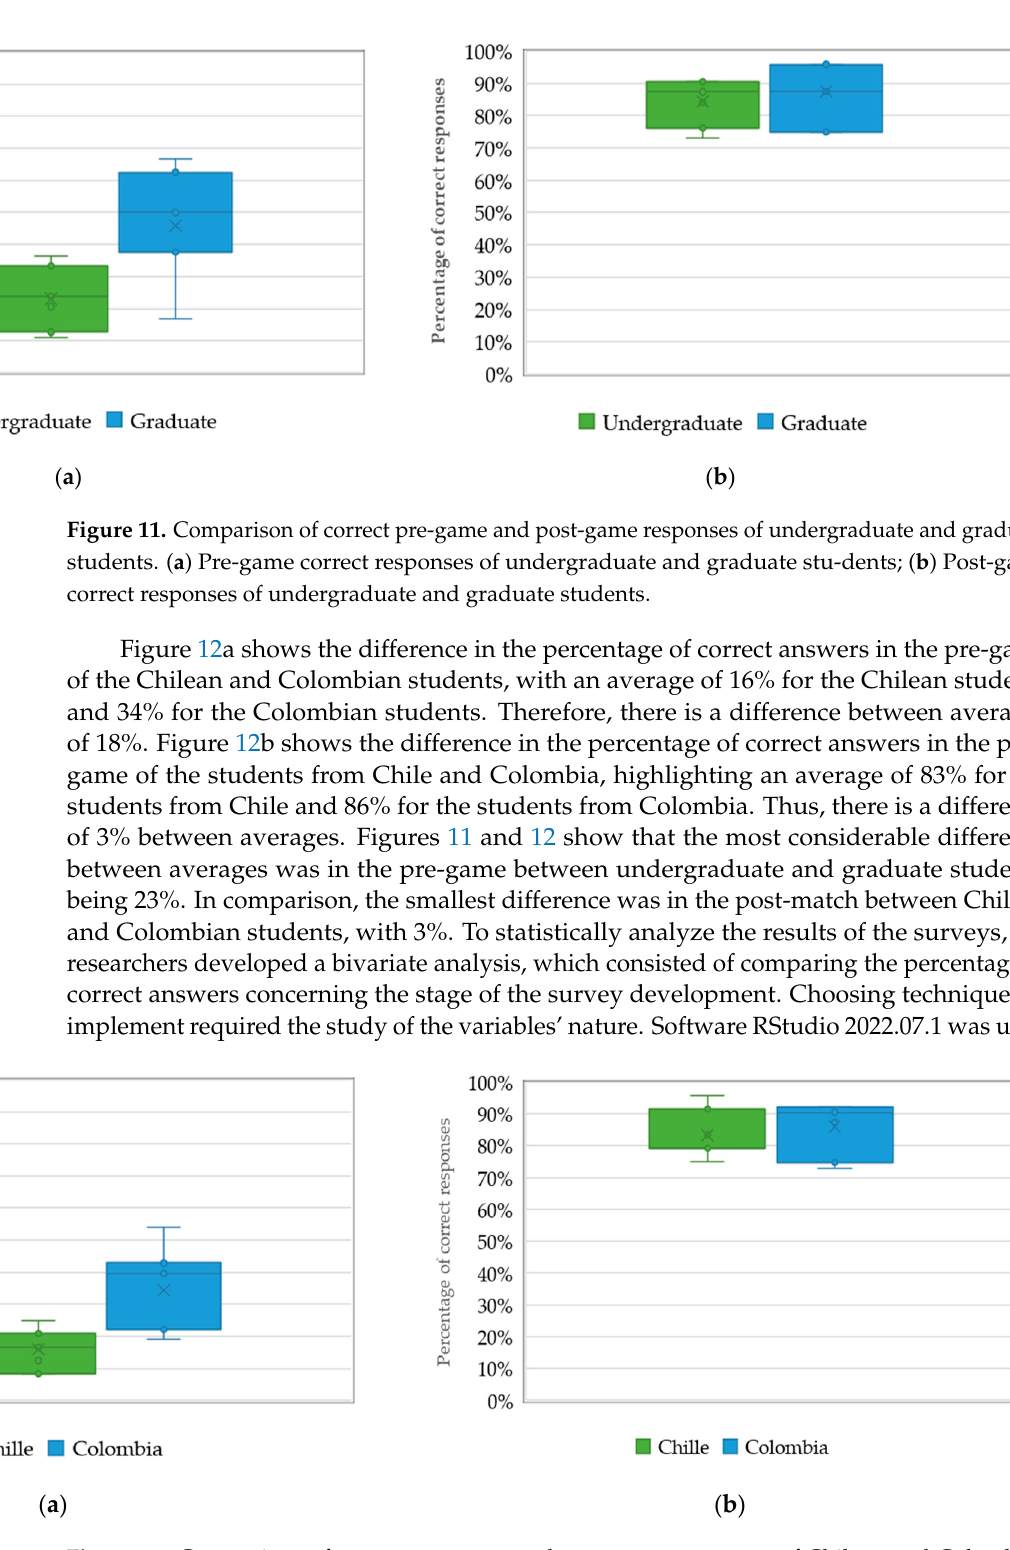
Figure 12. Comparison of correct pre-game and post-game responses of Chilean and Colombian students. ( a ) Pre-game correct responses of Chilean and Colombian stu-dents; ( b ) Post-game correct responses of Chilean and Colombian stu-dents